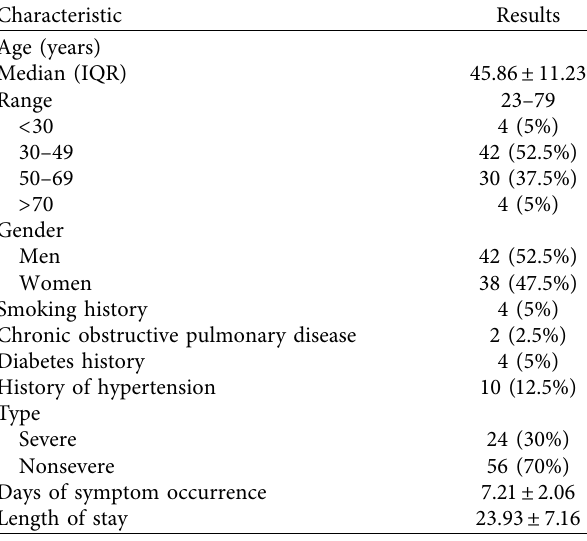
Table 1: Characteristics of the patients infected with COVID-19 ( n �